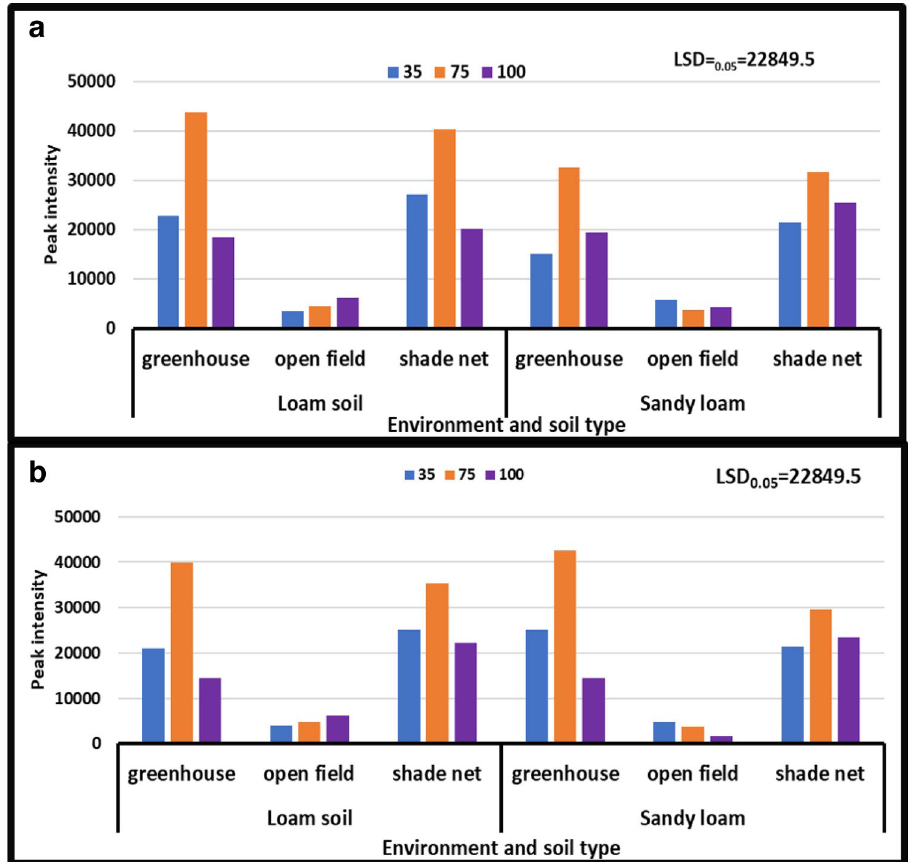
Figure 7. Treatment interaction effect on Kynurenine of African horned cucumber fruit. 35 means severe water stress; 75 means moderate water stress; 100 means no water stress; ( a ) means treatment interaction of irrigation water levels and soil types at different growing environments during the 2017/18 season; ( b ) means treatment interaction of irrigation water levels and soil types at different growing environments during the 2018/19 season. Values are average over treatment. Peak intensity showing LCMS-8040 triple quadrupole mass spectrometer intensities which represent the quantity of metabolites varying with treatments. LSD 0.05 is the least significant difference of